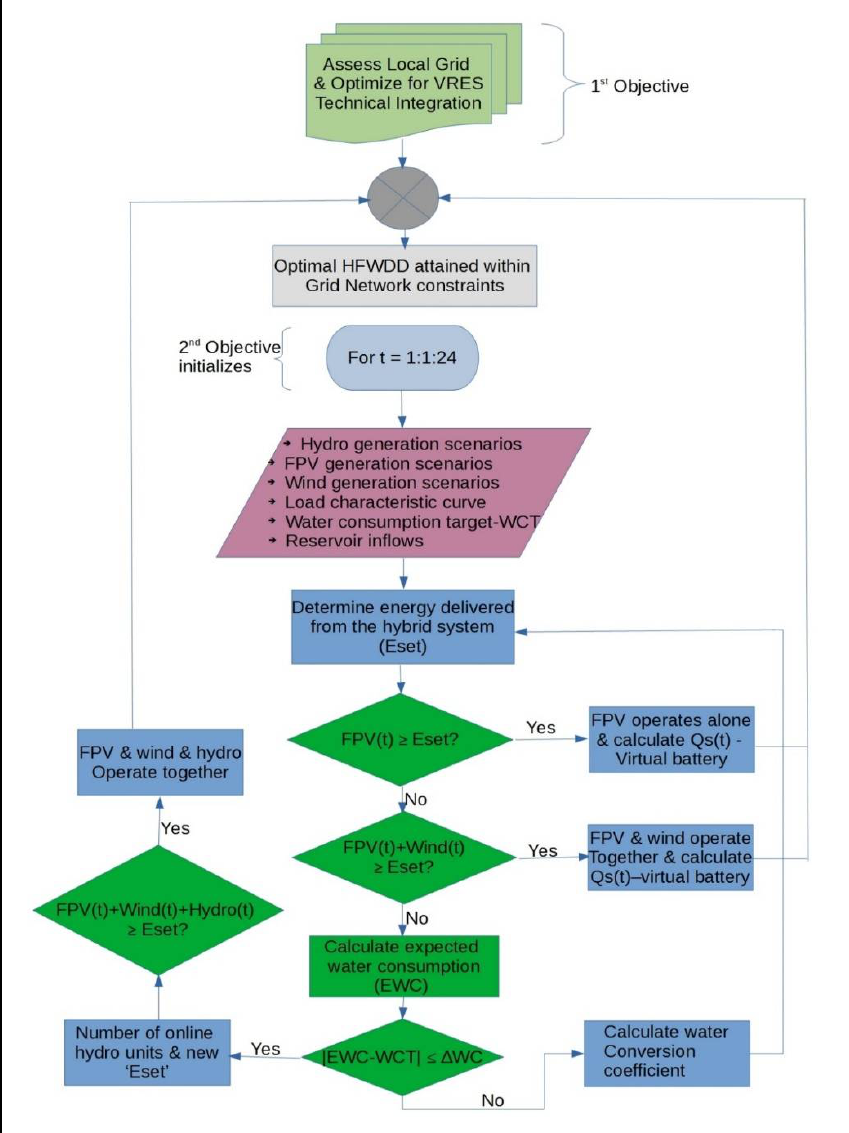
Figure 6. Diagram showing the systematic flow of the decision level to attain optimal hydro-FPV- wind daily dispatch (HFWDD).